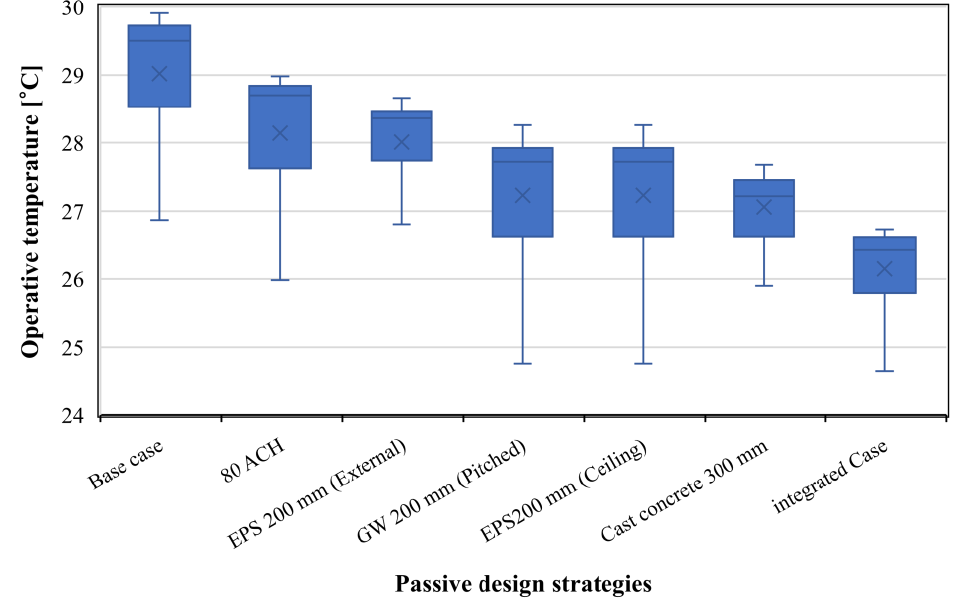
Figure 18. Box plots of operative temperature at optimum and integrated passive strategy.